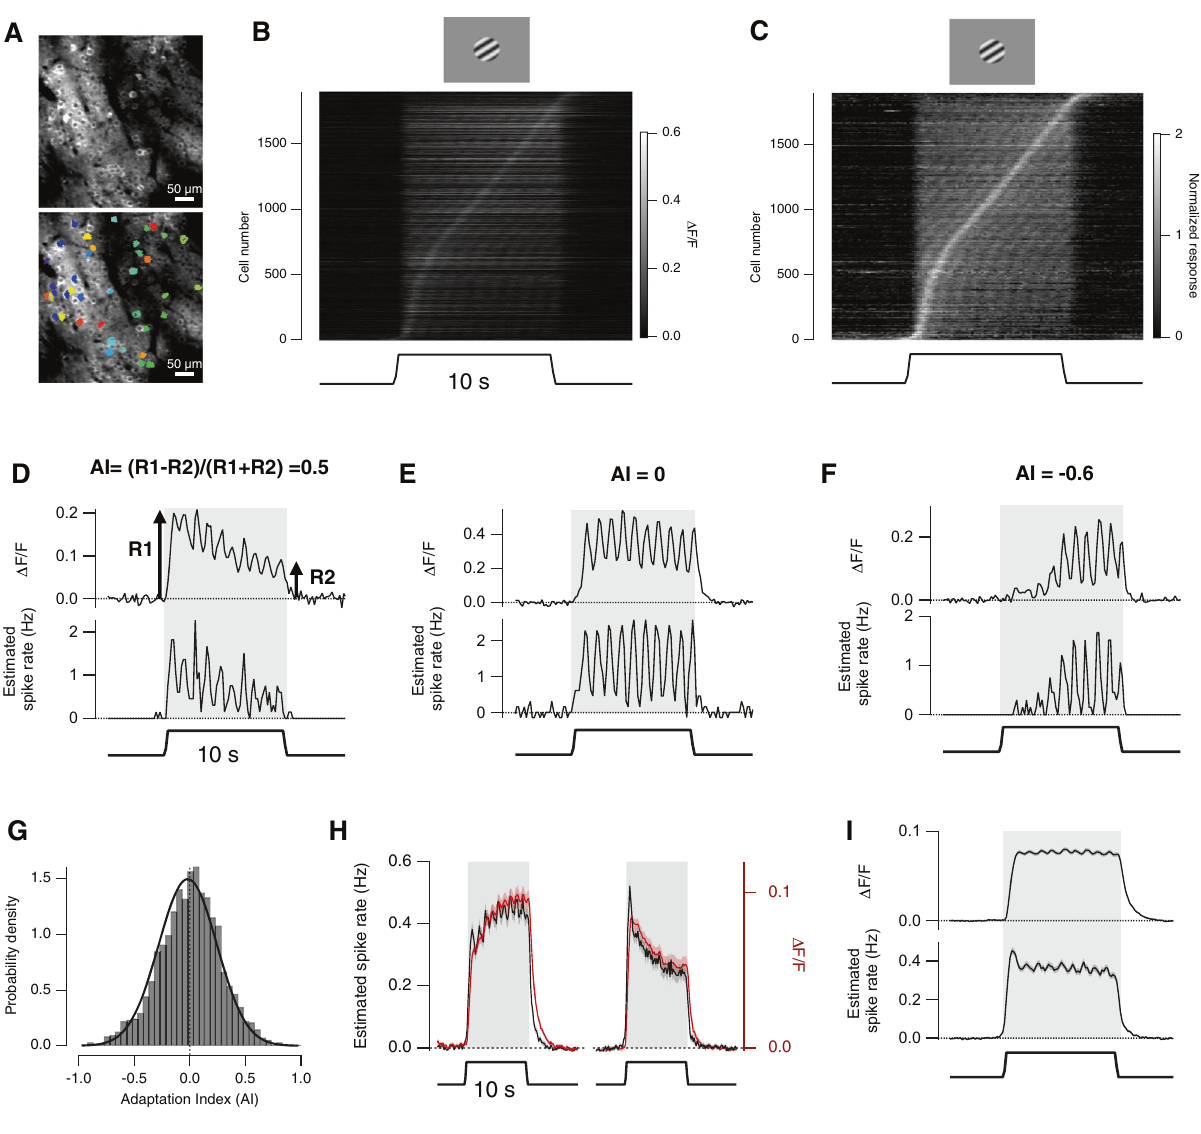
Fig. 1 Opposite forms of plasticity in pyramidal cells. A Example of a fi eld of view containing pyramidal cells (PCs) expressing GCaMP6f (top) and corresponding regions-of-interest (ROIs) de fi ning individual neurons (bottom, see “ Methods ” section). B Raster plot showing responses of 1896 PCs to a high-contrast stimulus applied for 10 s (average of ten trials, collected from 18 mice). Image showed in A is an example of this population. C Results from B in which responses have been normalized relative to their peak amplitude and then sorted according to time of peak. Note that some cells generate their strongest response at the onset of the stimulus while others gradually sensitize. The phase shift between the stimulus and GCaMP signal was correlated with the adaptive index (AI) of the PC causing tilted bands to appear when responses were ordered this way. D – F Averaged responses of individual neurons measured with GCaMP (top) and then re-expressed as estimated spike rate (bottom), calculated using MLSpike algorithm. For each, an AI was calculated as ( R 1 − R 2)/( R 1 + R 2) where R 1 is the average response over the fi rst 2 s of the stimulus and R 2 the average response to the last 2 s. The AI of each neuron was 0.5 ( D depressing adaptation, cell 150 in C ), 0 ( E no adaptation, cell 1031) and − 0.6 ( F sensitizing, cell 1613). G Distribution of the AI of 1896 PCs, calculated from GCaMP signals. The Gaussian fi t is centered on AI = − 0.019 with a sd of 0.26. A t -test and bootstrap test indicated that the mean AI was not signi fi cantly different from zero ( p = 0.16, two-tailed t -test). H Comparison of GCaMP signals (red) and estimated spike rates (black) for PCs in the fi rst 25% (left) and last 25% (right) of the distribution in G . Note the close correlation in the magnitude and direction of adaptive changes. I The averaged GCaMP signal (top) and estimated spike rate (bottom). Note the lack of contrast adaptation when the complete population of PCs is considered. Data are represented as mean ± SEM (shading area in D – F , H , I ) or probability density ( G ). Source data are provided as a Source Data fi